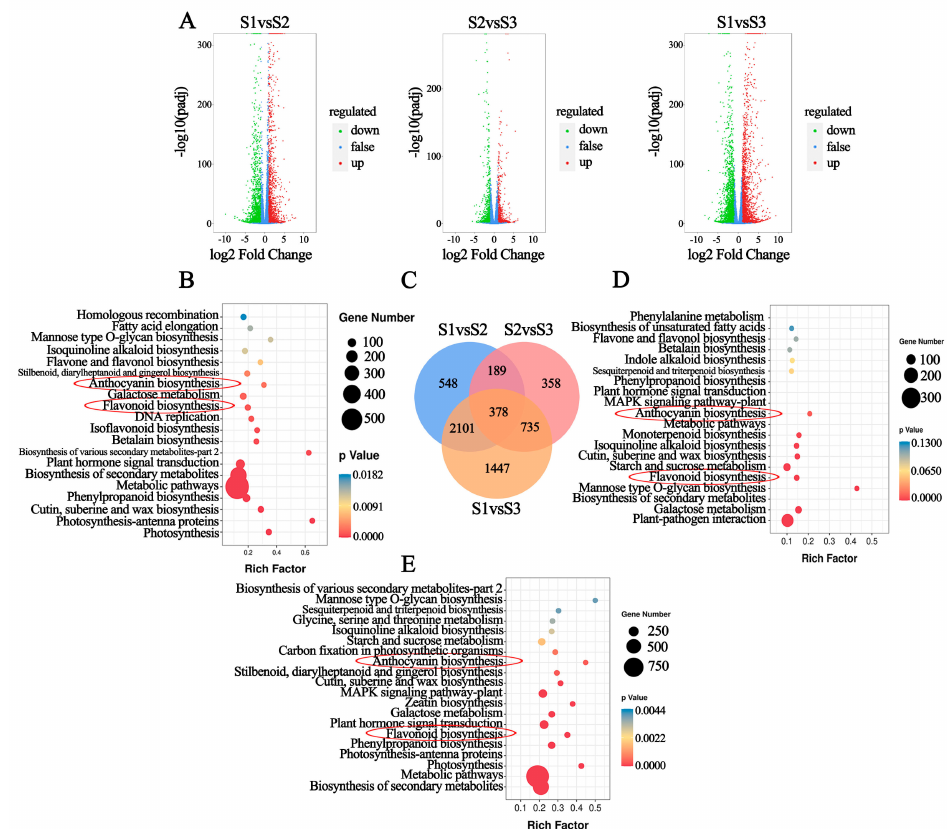
Figure 4. Identification and Kyoto Encyclopedia of Genes and Genomes (KEGG) enrichment of differentially expressed genes (DEGs) in three developmental stages of red P. bournei leaves. ( A ) Vol- cano plots of DEGs; green, red, and blue dots represent the downregulated, upregulated, and non-differentially expressed genes, respectively; ( C ) Venn diagram of DEGs in each comparison group. KEGG enrichment analysis of the DEGs between; ( B ) S1 vs. S2; ( D ) S2 vs. S3 and ( E ) S1 vs.